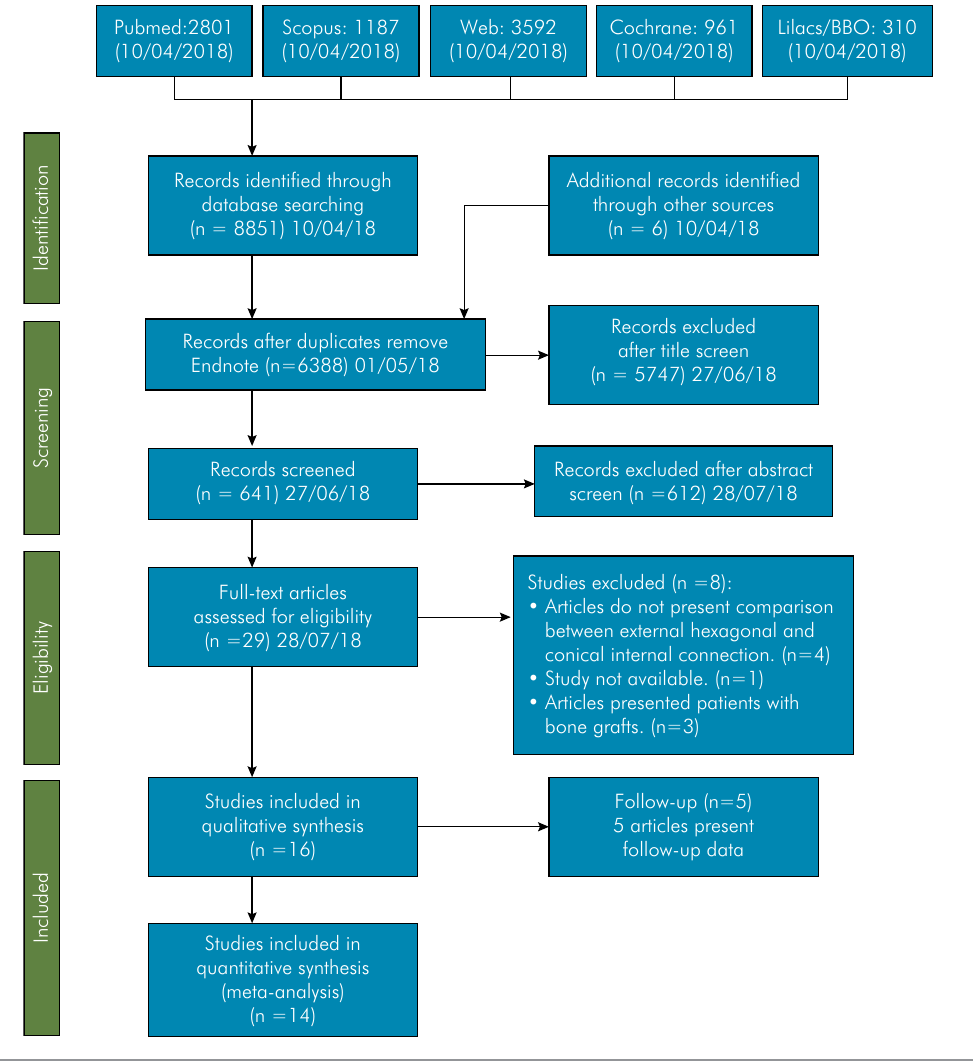
Figure 1. Present study’s flow